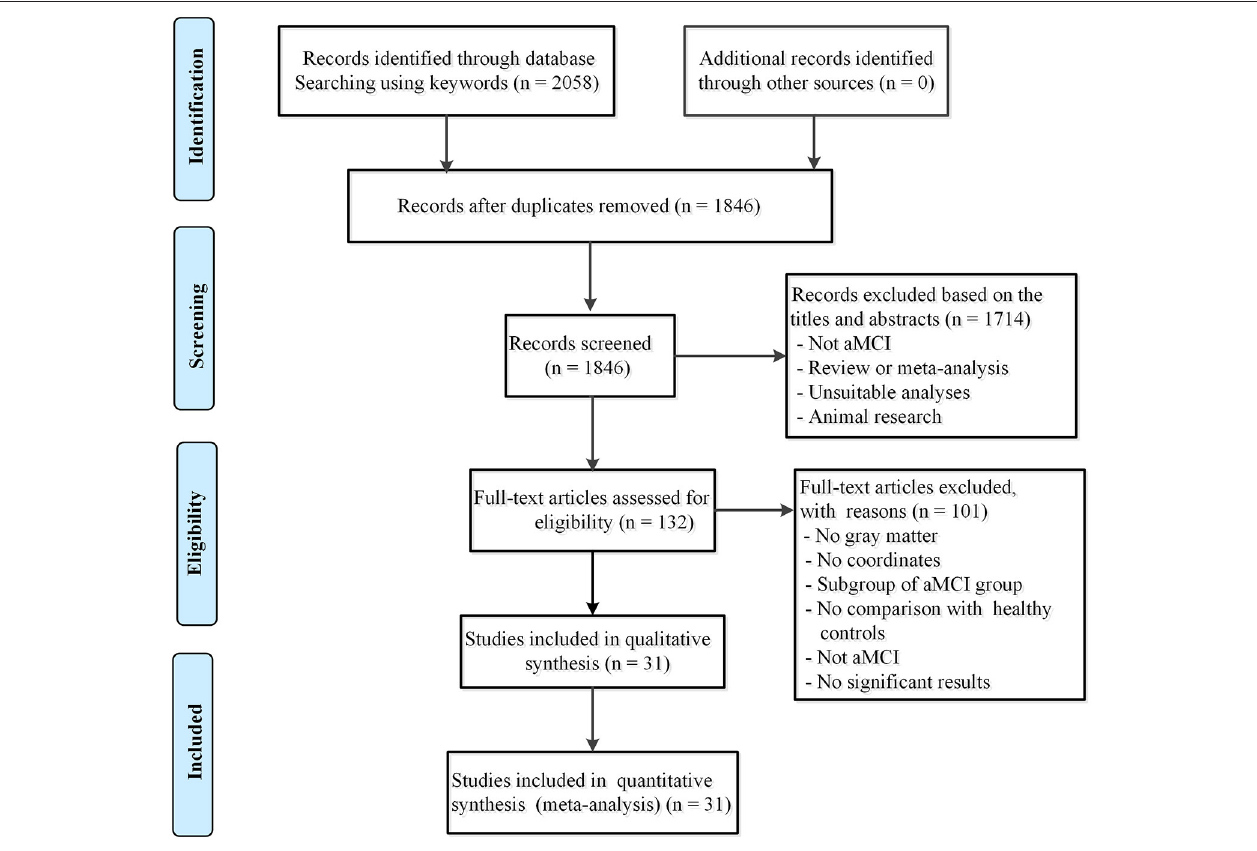
FIGURE 1 | Flow diagram of inclusion and exclusion process of selected articles of VBM studies in patients with aMCI. aMCI, amnestic mild cognitive impairment.